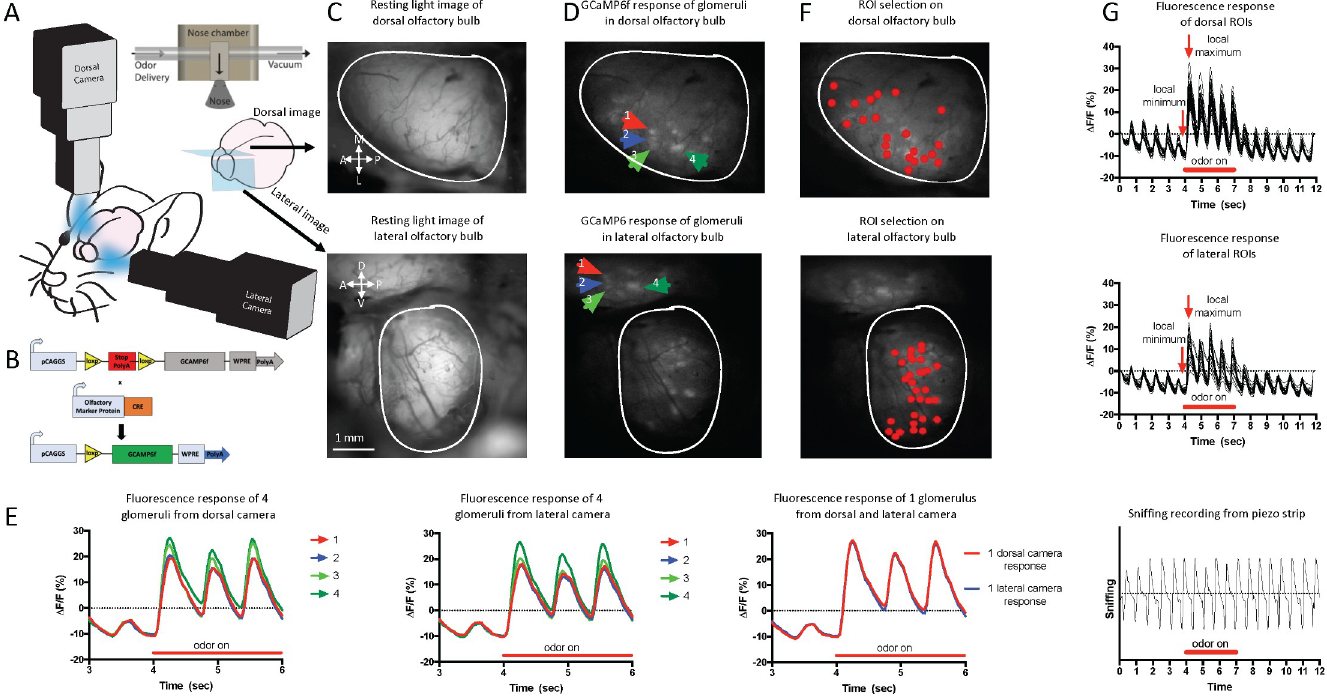
Fig 1. Dual imaging of the dOB and lOB in GCaMP6f reporter mice. (A) Schematic representation of the dual microscope imaging setup. Illustrating the plane of the dorsal and lateral images. Inset: schematic of the odor delivery assembly relative to the nostrils, illustrating the odor and vacuum flow channels. (B) Schematic of the mouse genotype. (C) Top: resting light image of the dOB. Bottom: resting light image of the lateral region of the OB. (D) Top: odor-induced activation map of the dOB. Arrows highlight 4 individual glomeruli. Bottom: odor-induced activation map of the lOB. Arrows point to the same 4 glomeruli as top. (E) Left: glomerular response traces from the 4 glomeruli imaged with the dorsal camera in response to 1% heptanone. Middle: responses from the 4 glomeruli imaged with the lateral camera in response to 1% heptanone. Right: glomerulus 4 imaged from the dorsal and lateral camera, overlaid. (F) Top: an example of the ROI selection on the dorsal bulb for 1 animal. Bottom: an example of the ROI selection for the lateral bulb for 1 animal. (G) Top: % Δ F/F responses for the dorsal ROIs in panel F (top) selection of first odor response is indicated (1 animal). Middle: % Δ F/F responses for the lateral ROIs in panel F (Bottom) (1 animal). Bottom: a sniffing trace from the same animal. Inhalation is the upward inflection (see Methods for details). Underlying data for this figure can be found in S1 Data. dOB, dorsal olfactory bulb; lOB, lateral olfactory bulb; OB, olfactory bulb; ROI, region of interest.